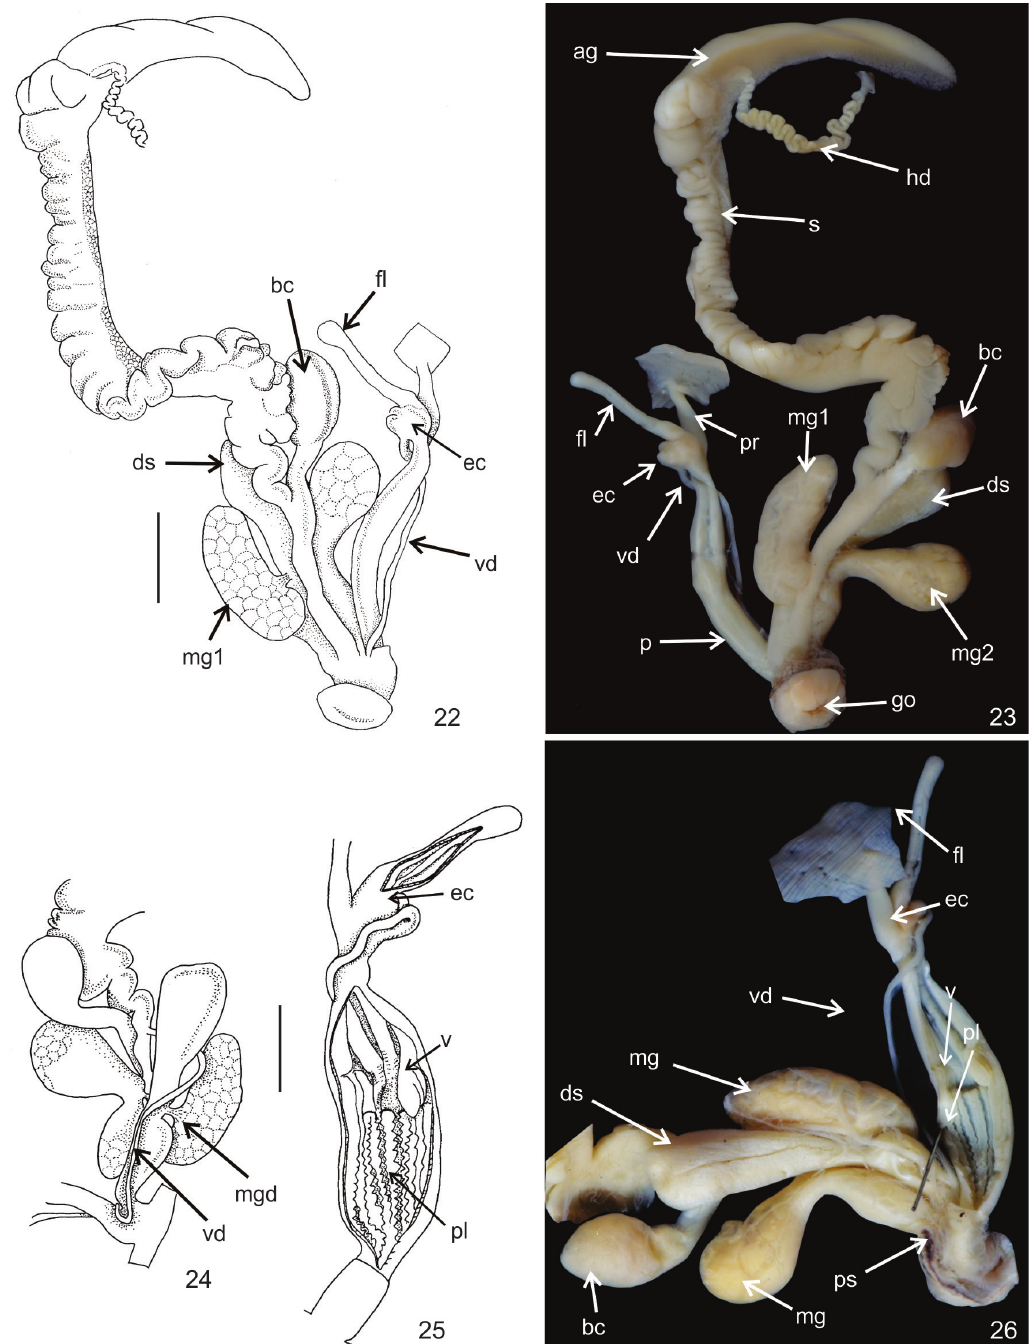
mm.M. Figures 22–26. Genital system: (22, 23) line drawing and photograph of the complete dissected out reproductive system (ag) albumen gland, (bc) bursa copulatrix, (ds) dart sac, (ec) flagellar caecum, (fl) flagellum, (go) genital opening, (hd) hermaphroditic duct, (mg1) mucous gland 1, (mg2) mucous gland 2, (p) penis, (pr) penial retractor muscle, (s) spermoviduct, (vd) vas deferens; (24) detail of the terminal genitalia (pl) penial plates, (ps) penial sheath, (v) verge; (25) vas deferens and insertion of mucous gland ducts into dart sac (mgd) mucous gland duct; (26) inner sculpture of the penial complex showing the verge inside the penis. Scale bars: 22 and 25 = 5 ZOOLOGIA 34: e13230 | DOI: 10.3897/zoologia.34.e13230 | April 27, 20178 /